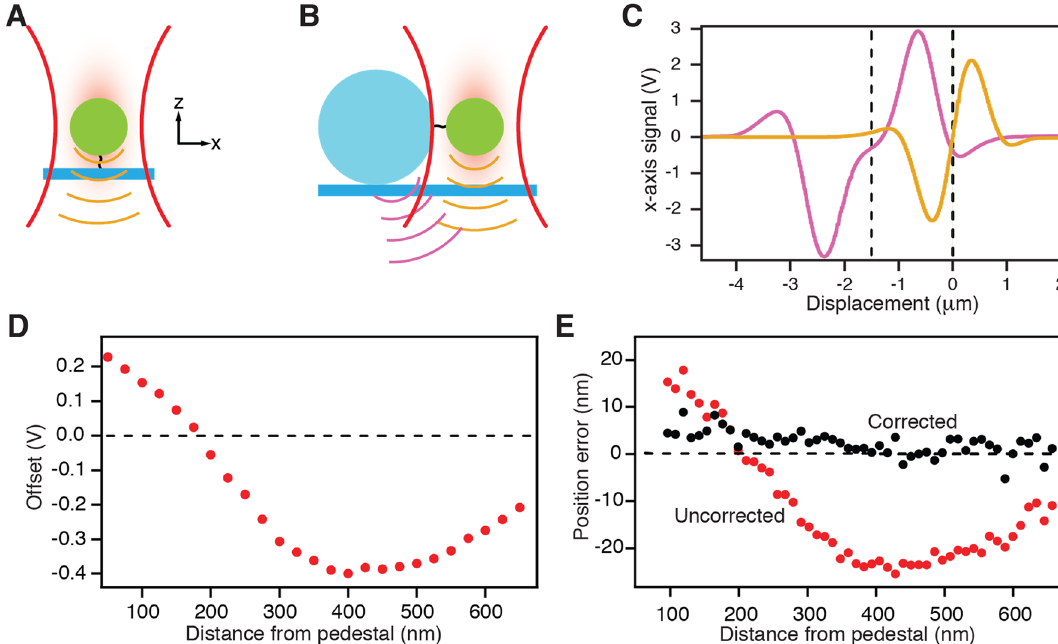
Figure 1. Apparatus and control experiments. ( A ) When a probe is held in an optical trap (red), its position can be measured along three axes by capturing transmitted and forward-scattered light (orange) on a quadrant photodiode. ( B ) A stationary pedestal, to which one end of a filamentous protein is attached, scatters a small fraction of the incident light and contaminates the desired signal for the probe. ( C ) Control measurements show the signals as a function of offset position due to the probe alone and to the pedestal alone. The two signals have been offset by 1.5 µm (dashed lines) to simulate the configuration during an actual experiment. ( D ) With the probe fixed in place, moving the pedestal nearby produces a spurious offset signal. The dashed line shows the reference signal for the probe far from the pedestal. ( E ) The systematic error in position measurements owing to the pedestal is reduced by the compensation procedure to a few